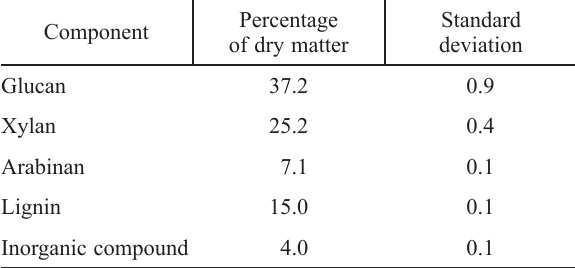
Table 1 – Corn stover compositional analysis. Standard de- viations are calculated from triplicates.